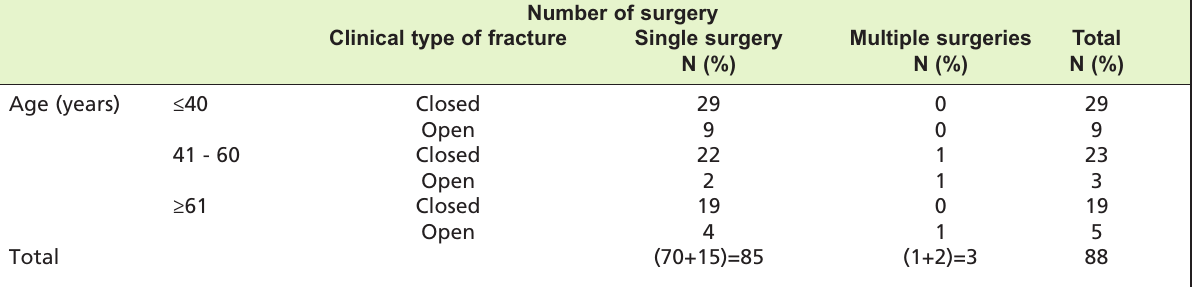
Association between age, clinical type of the fracture and number of surgeries Table III: